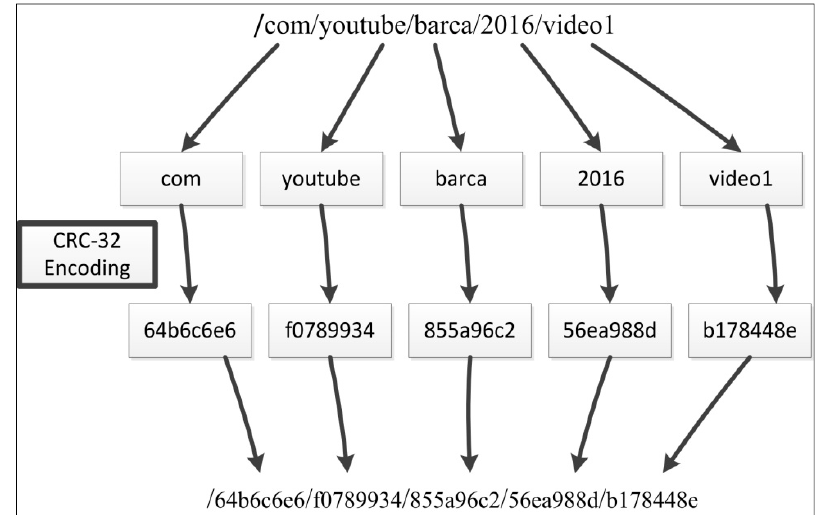
Figure5. Encoding name prefix based on CRC-32. Figure 5. Encoding name prefix based on